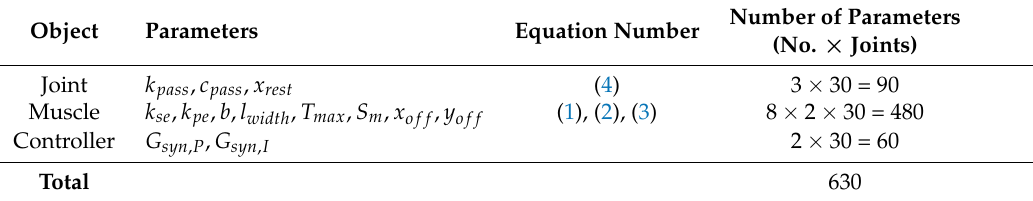
Table 3. Parameter values to